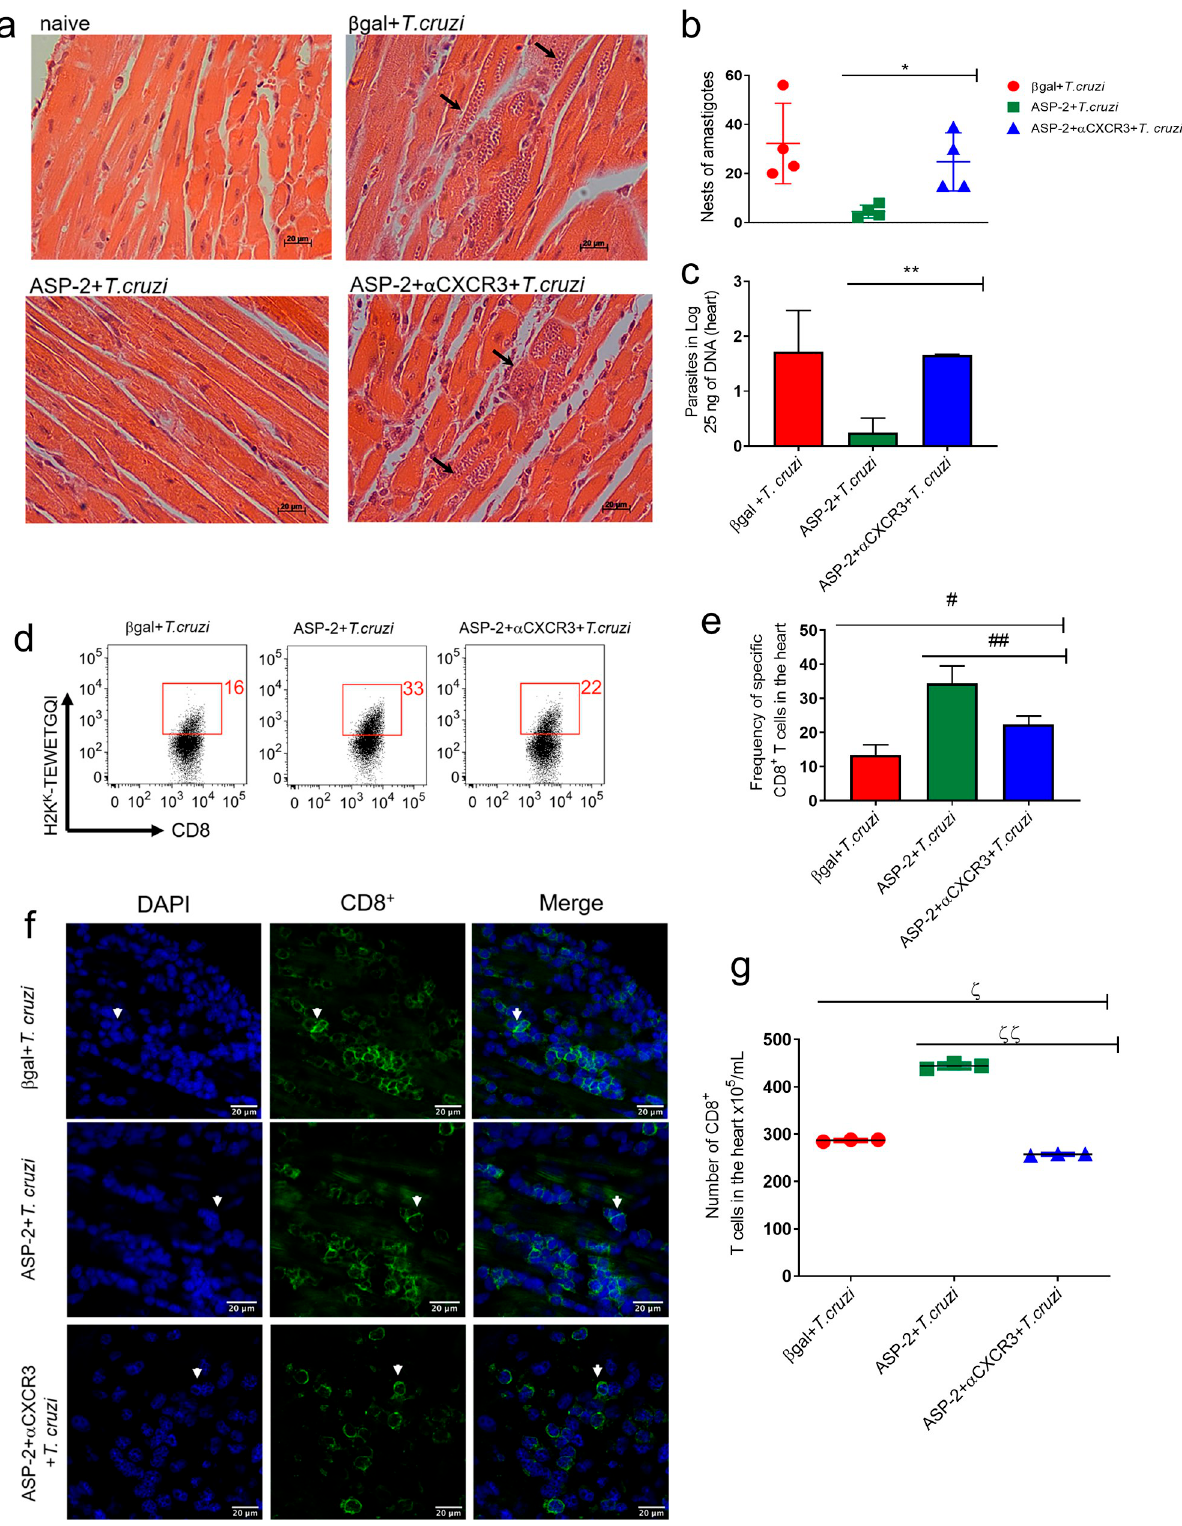
Fig 8. The migration of specific CD8 + T cells to heart was impaired after treatment with anti-CXCR3 antibody. a-Histological section from heart tissue: the black arrows show the amastigotes nests in β gal+ T . cruzi ,ASP2+ T . cruzi ,and ASP2+ α CXCR3+ T . cruzi groups. b-Graph represents the